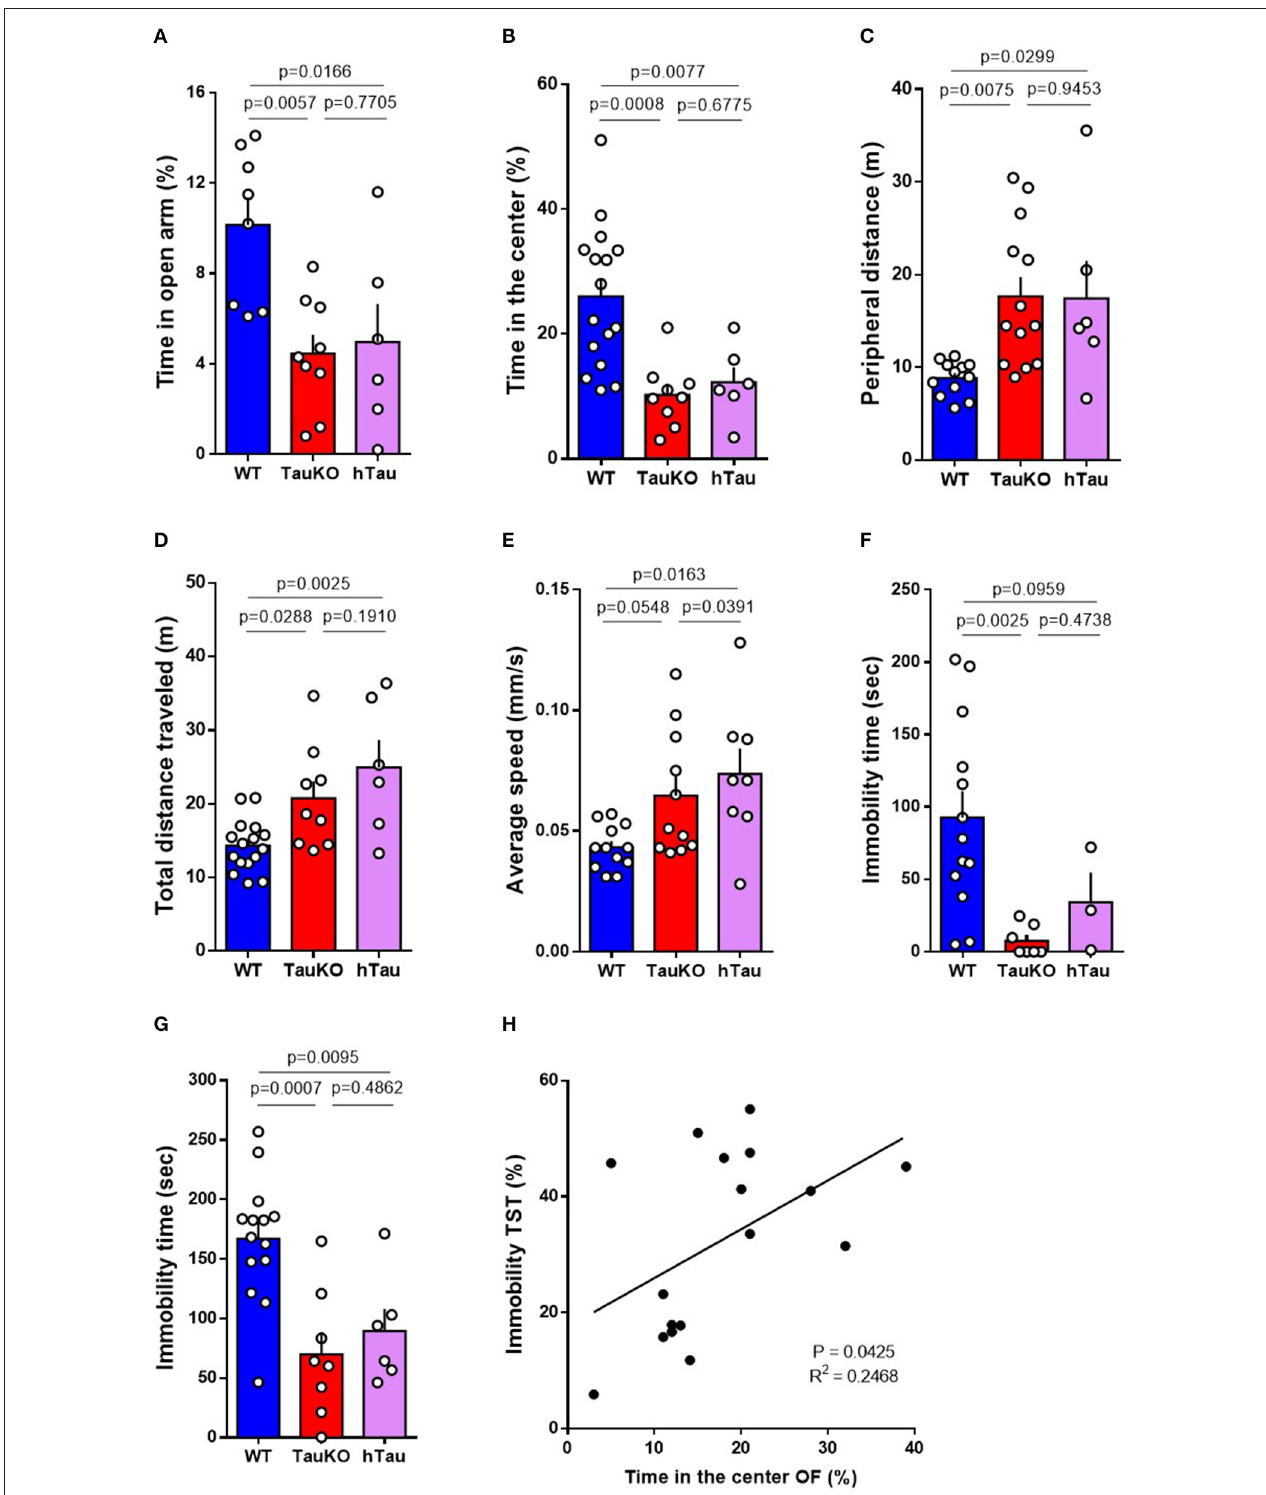
FIGURE 2 | Patterns of anxiety-related behaviors in TauKO and hTau mice. (A) Analysis of the time spent in the open arms of the elevated zero maze expressed in percentage of time relative to the 5 min’ test length. Test performed with 15–19 weeks old WT, TauKO, and hTau mice ( n = 8 WT; 9 TauKO; 6 hTau). (B–E) Open field test performed with 15–19 weeks old WT, TauKO, and hTau mice ( n = 12–16 WT; 9–13 TauKO; 6–8 hTau). (B) Analysis of the time spent in the center of the apparatus expressed in percentage of time relative to the 5 min’ test length. (C) Analysis of the total distance moved in the periphery of the apparatus. (D) Analysis of the total